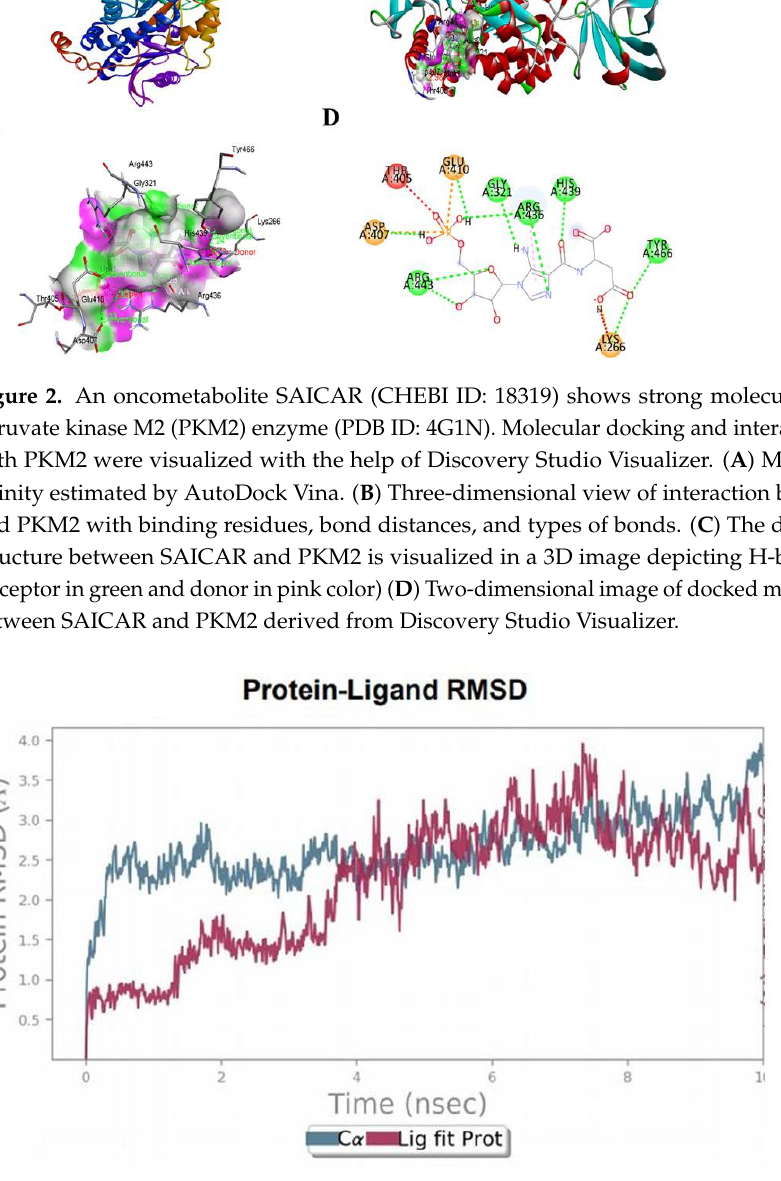
Figure 2. An oncometabolite SAICAR (CHEBI ID: 18319) shows strong molecular binding with py- ruvate kinase M2 (PKM2) enzyme (PDB ID: 4G1N). Molecular docking and interaction of SAICAR with PKM2 were visualized with the help of Discovery Studio Visualizer. ( A ) Molecular docking affinity estimated by AutoDock Vina. ( B ) Three-dimensional view of interaction between SAICAR and PKM2 with binding residues, bond distances, and types of bonds. ( C ) The docked molecular structure between SAICAR and PKM2 is visualized in a 3D image depicting H-bond interactions (acceptor in green and donor in pink color) ( D ) Two-dimensional image of docked molecular struc- ture between SAICAR and PKM2 derived from Discovery Studio Visualizer.